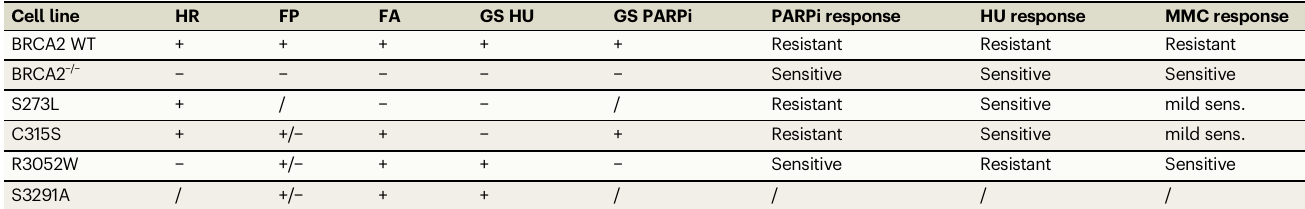
Table 1 | Main phenotypes observed in the different DLD1 BRCA2-mutated stable cell lines used in this study Cell